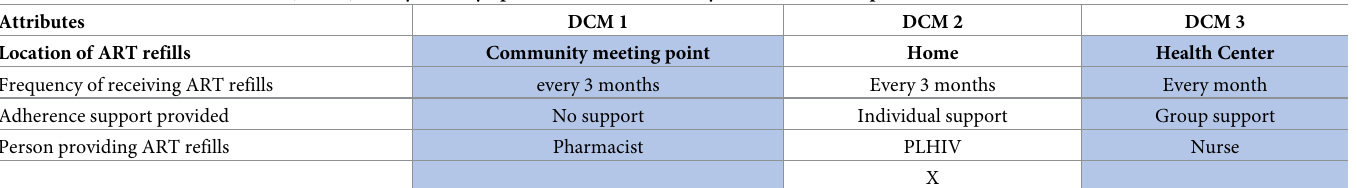
Table 2. Example of choice